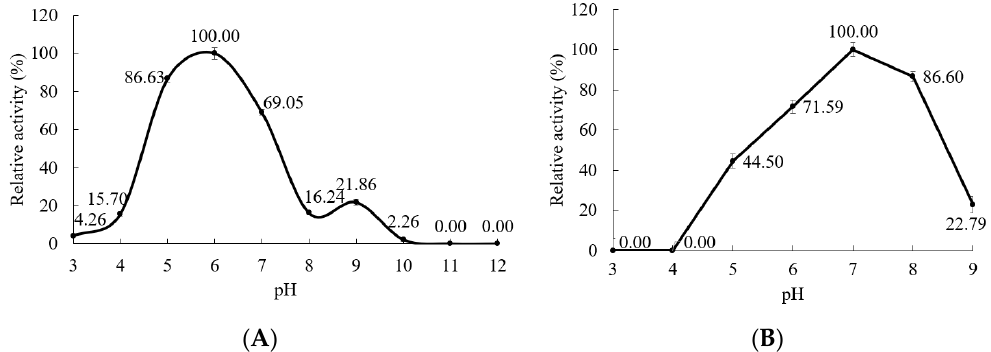
Figure 12. Effect of pH on α -amylase activity and stability. ( A ) Effect of pH on α -amylase activity. The α -amylase activity was measured under 70 °C, 1% (w/v) starch, 20 min, and different pHs. ( B ) Effect of pH on α -amylase activity and stability. The purified BvAmylase was preincubated in varying pH (3–9) in the respective buffer for 48 h, and the residual enzyme activity was tested by the DNS method. The highest activity and the highest residual activity were taken as the control (100%). All assays were repeated four times. All of the experimental groups were statistically different from the control experiment ( p < 0.01).